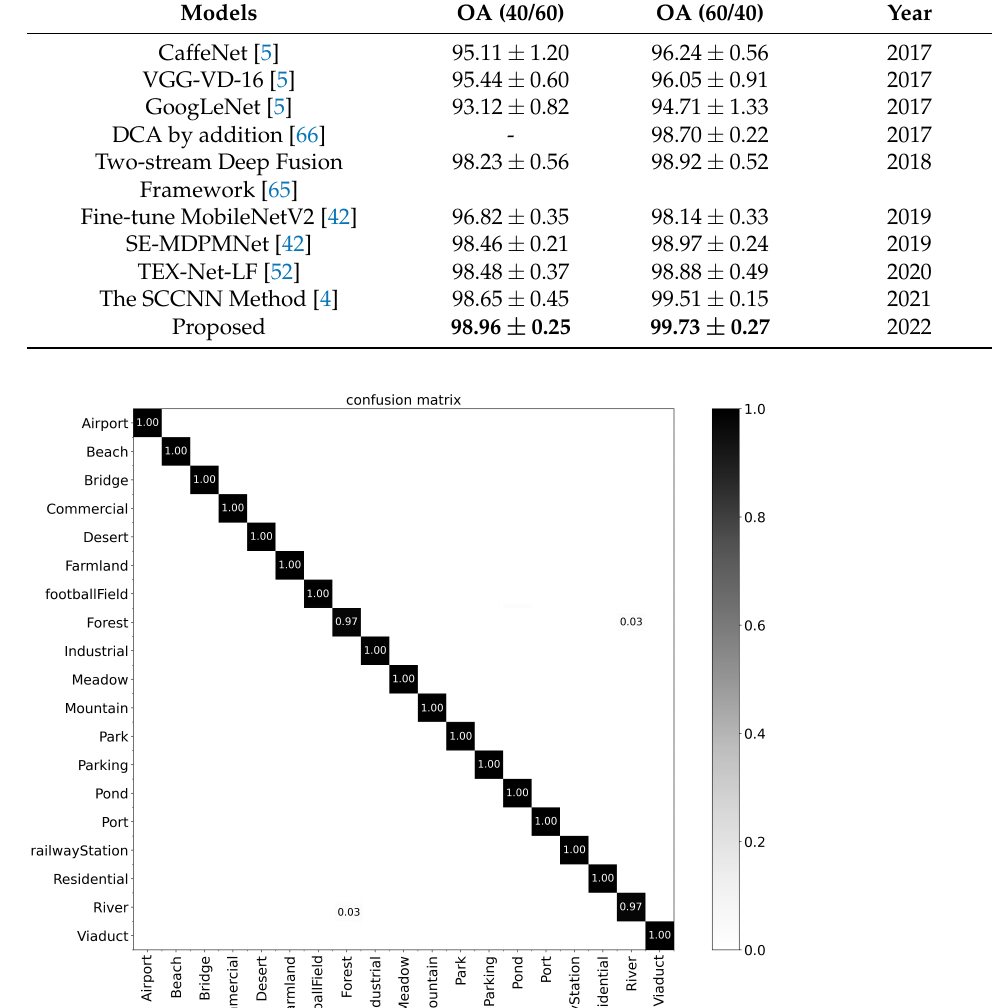
Table 10. OA comparison on WHU-RS dataset.